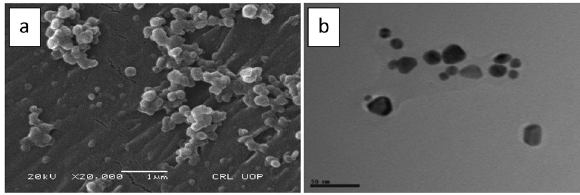
Figure 3: Electron microscopy of SE - mediated AuNPs: ( a ) scanning electron micrograph and ( b ) transmission electron micrograph.